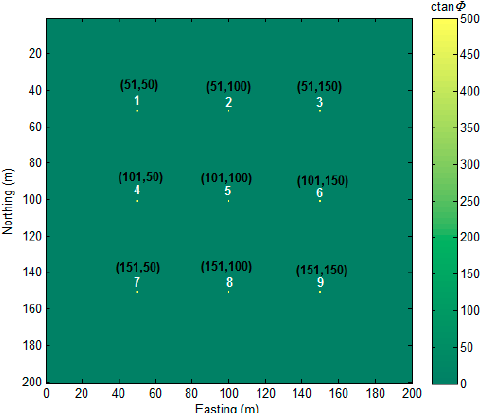
Figure 4. Magnetic Dipole Tangent Angle (MDTA) map of magnetic gradient tensor data. Black text represents the coordination of detected magnetic dipole location.